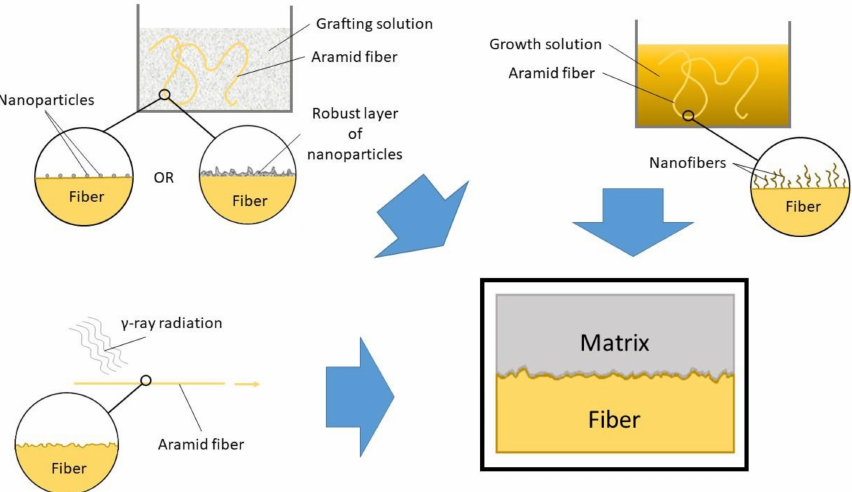
Figure 3. Schematic presentation of di ff erent methods to create mechanical bond between fiber surface and